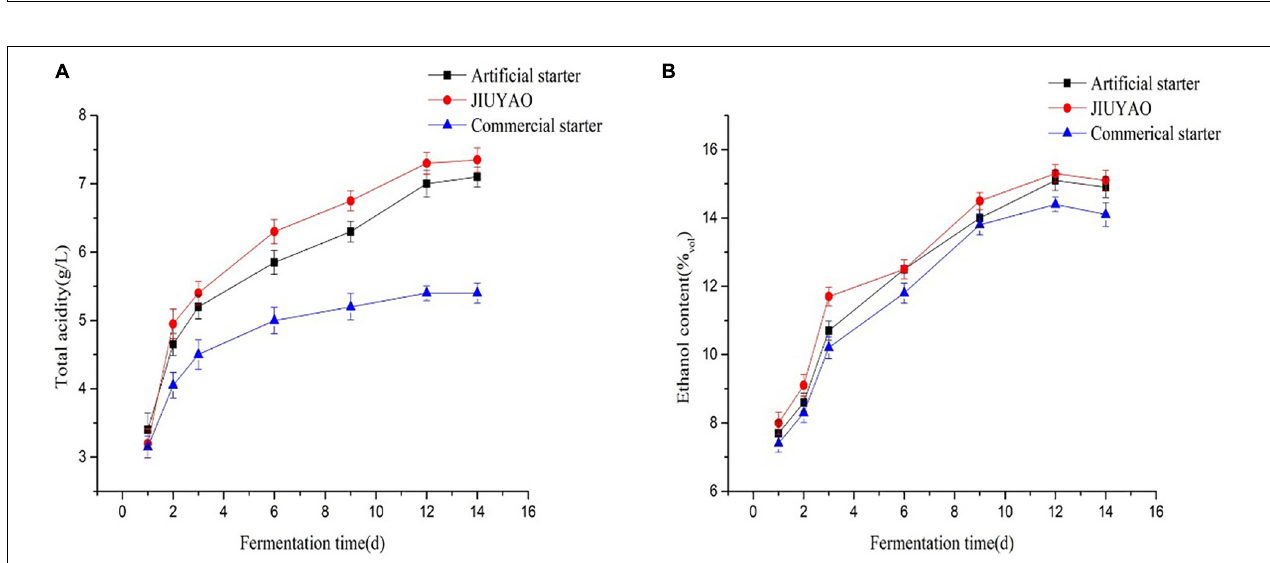
FIGURE 3 | Fermentation performance results of the three Chinese rice wine samples fermented with three different starter cultures. (A) Changes in the total acid contents during the fermentation process. (B) Changes in the ethanol contents during the fermentation process.